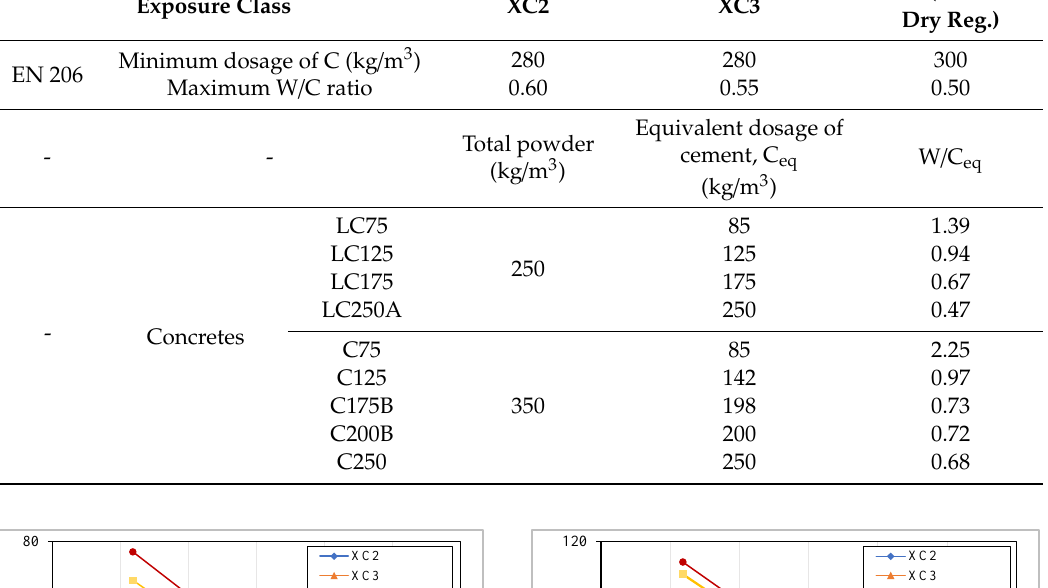
Figure 23. Relation between the c min,dur vs. dosage of C eq and between c min,dur vs. W/C eq .:( a ) current structures, total powder 250 kg/m 3 ; ( b ) current structures, total powder 350 kg/m 3 ; ( c ) special structures, total powder 250 kg/m 3 ; ( d ) special structures, total powder 350 kg/m 3 ; ( e ) current structures; ( f ) special structures.